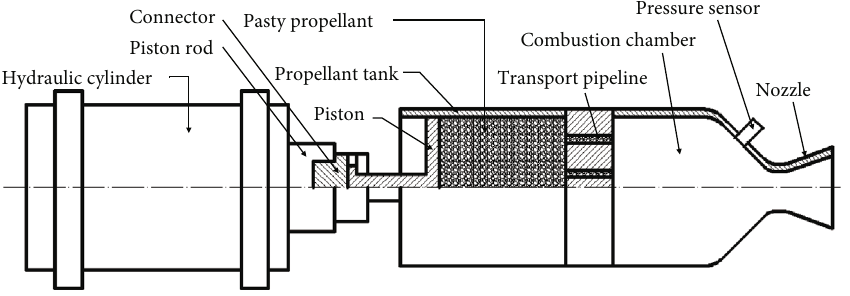
Figure 5: The schematic diagram of the laboratory-scale test pasty rocket engine.